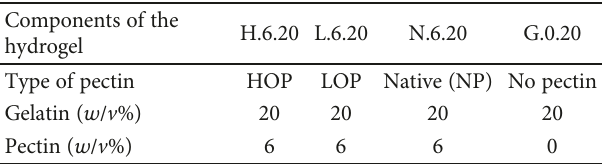
Table 2: Summary of hydrogel compositions. The percentages of pectin and gelatin weight were according to the total volume of the solution (e.g., in 10mL of distilled water, 2.0g of gelatin and 0.6 g of pectin are